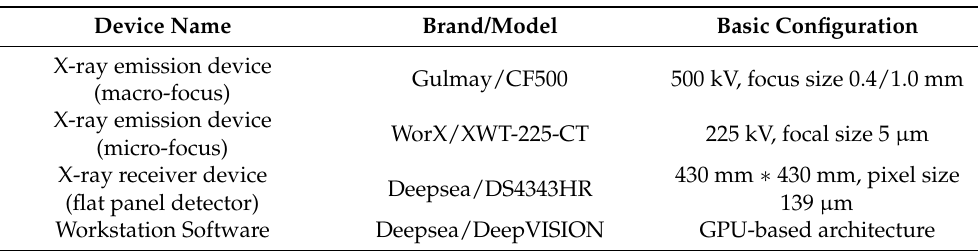
Table 2. The basic configuration of the core imaging chain components from the X-ray inspection equipment of Figure